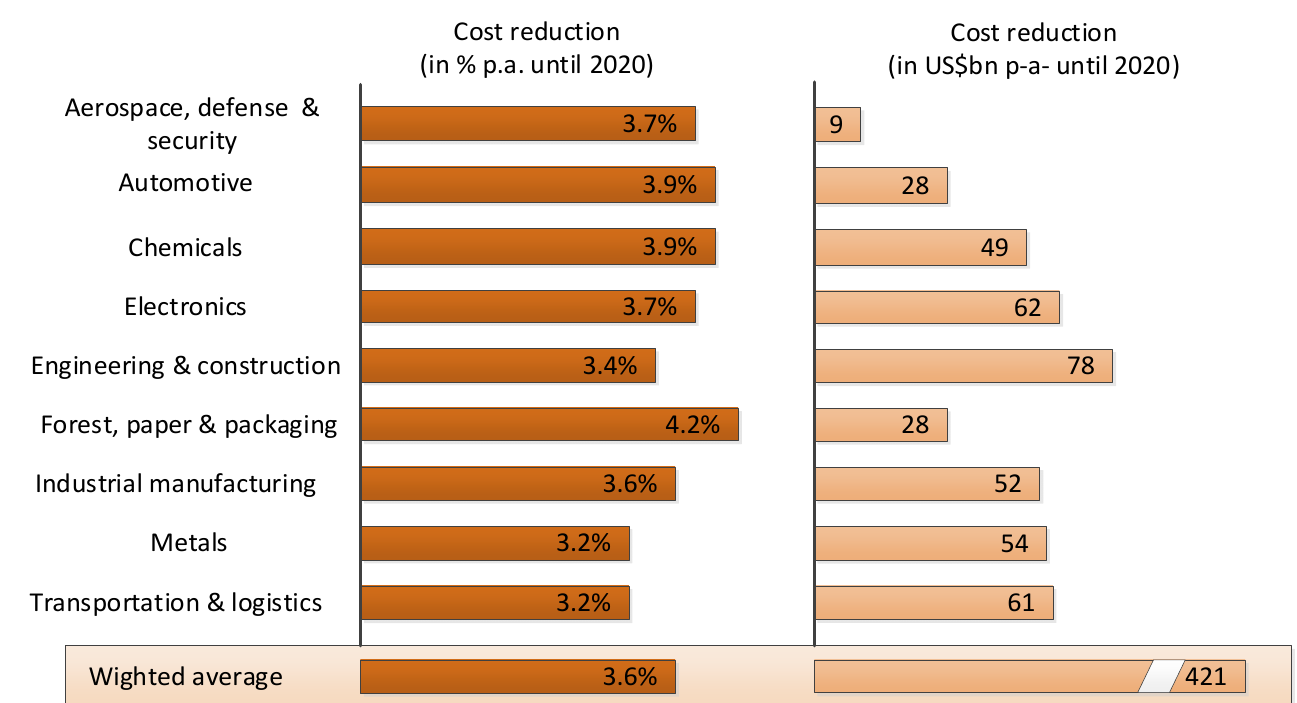
Figure 1. Annual cost reduction due to the incorporation of predictive maintenance techniques [1].